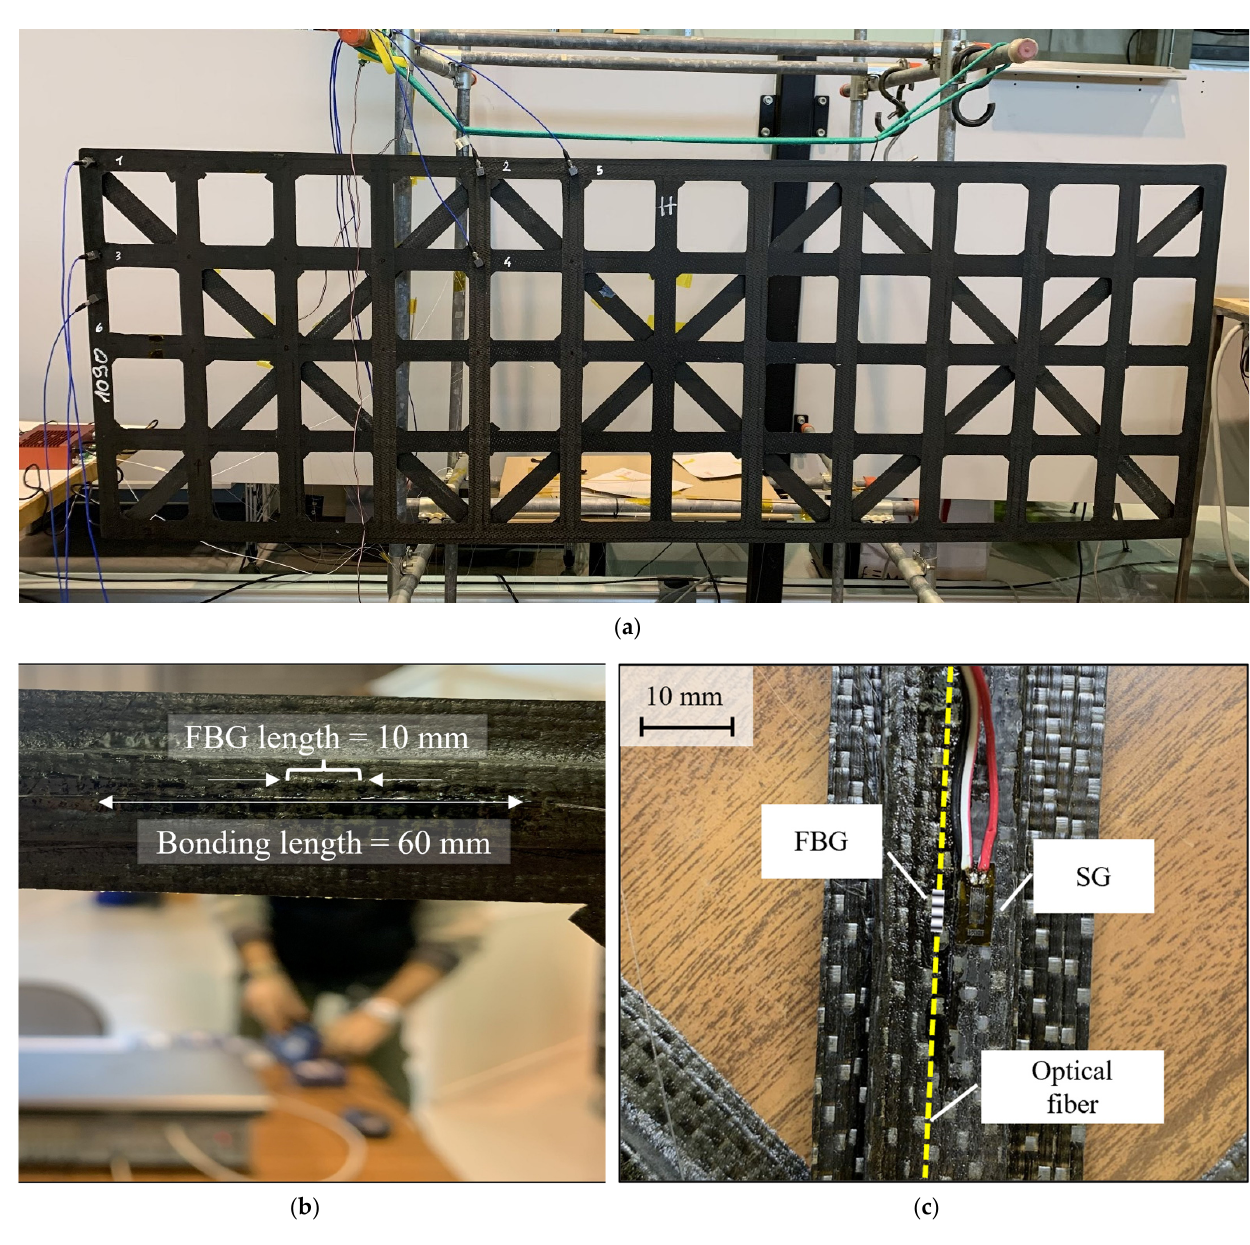
Figure 3. Experimental setup details: ( a ) Front view of the roof CFRP quadridirectional grid struc- ture; ( b ) Example of FBG bonding; ( c ) Electrical SG bonding in proximity to FBG 8. ( b ) Example of FBG bonding; ( c ) Electrical SG bonding in proximity to FBG An impact hammer (model: 086C04) and six Integrated Circuit-Piezoelectric (ICP ® ) accelerometers (models: 333B32, 333B35, 352C03), which are a specific type of Integrated Electronic Piezoelectric (IEPE) accelerometers, from PCB Piezotronics (Depew, NY, USA)